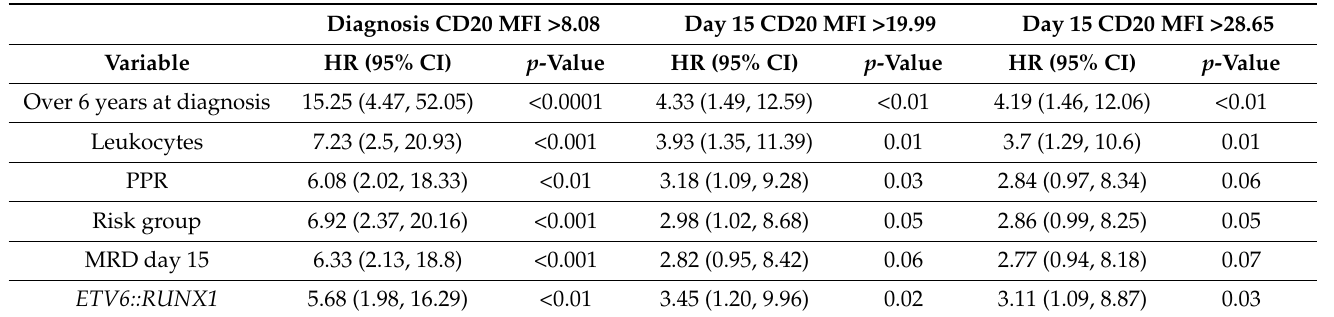
Table 4. Multivariable Cox regression model analysis of RFS.